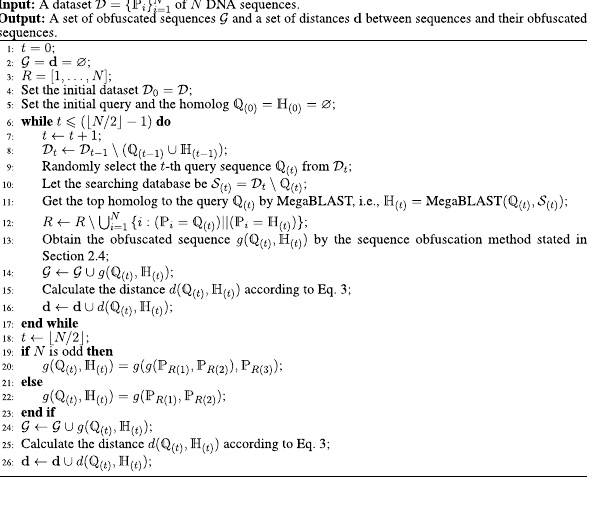
Algorithm 1. The algorithm for